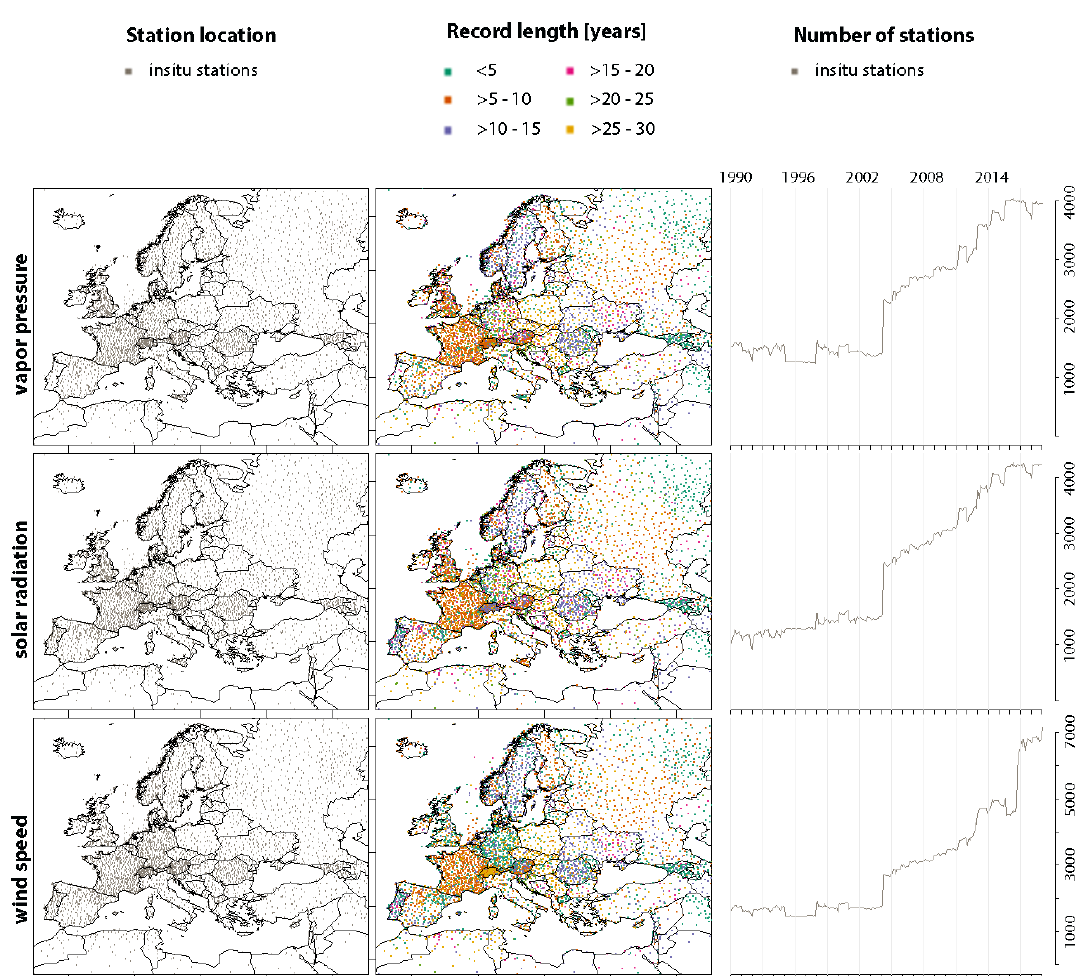
Figure 2. Input data for daily EMO-5 vapour pressure, solar radiation, and wind speed grids in terms of station locations, record lengths, and number of stations